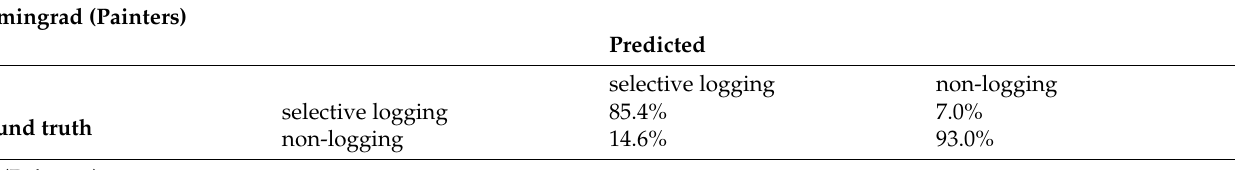
Table 2. Confusion matrices of the best accuracy obtained through the CNNs tested for each type of input image. Covmingrad (Painters)